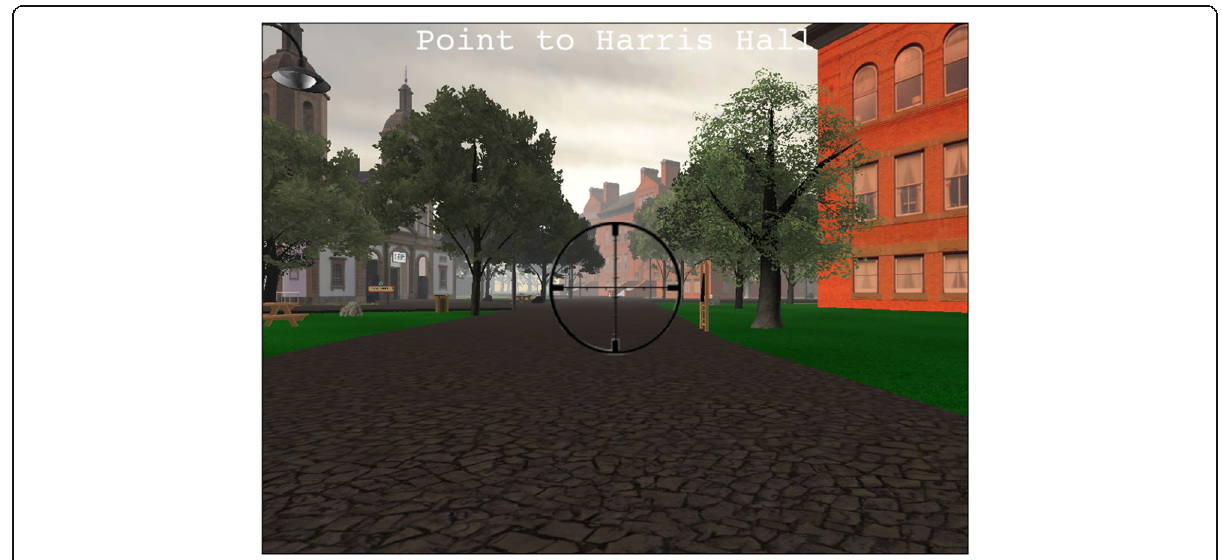
Fig. 3 Pointing task. Participants could rotate a virtual crosshair 360 o along the horizontal plane to point in the direction of a target